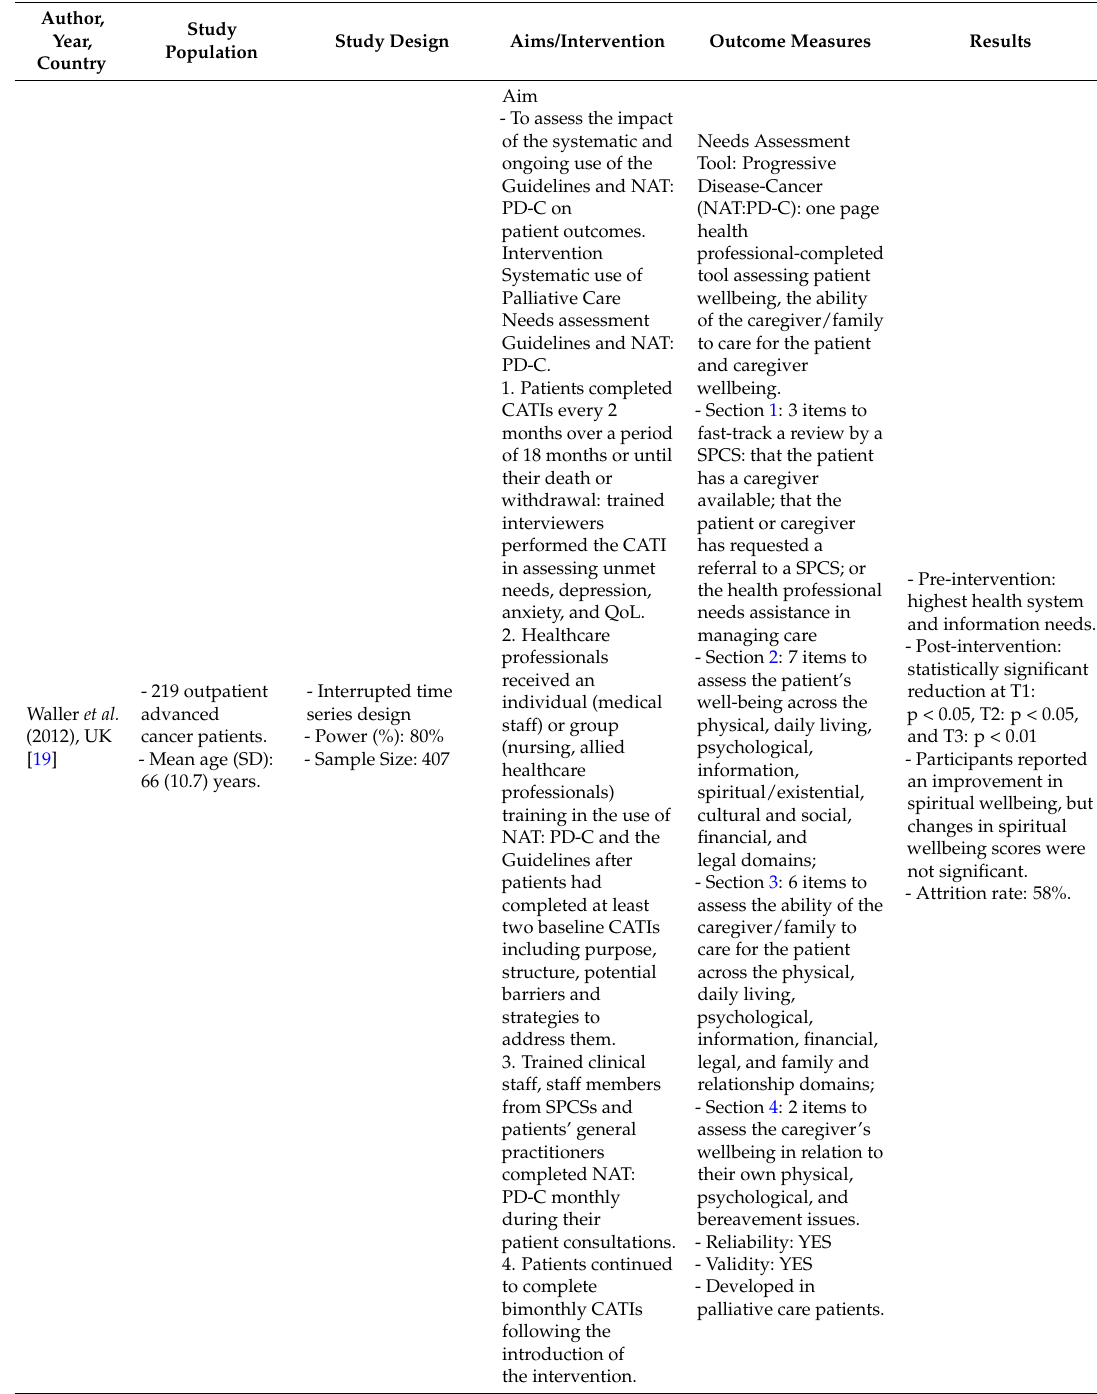
Table 1. Characteristics of the included studies (N =